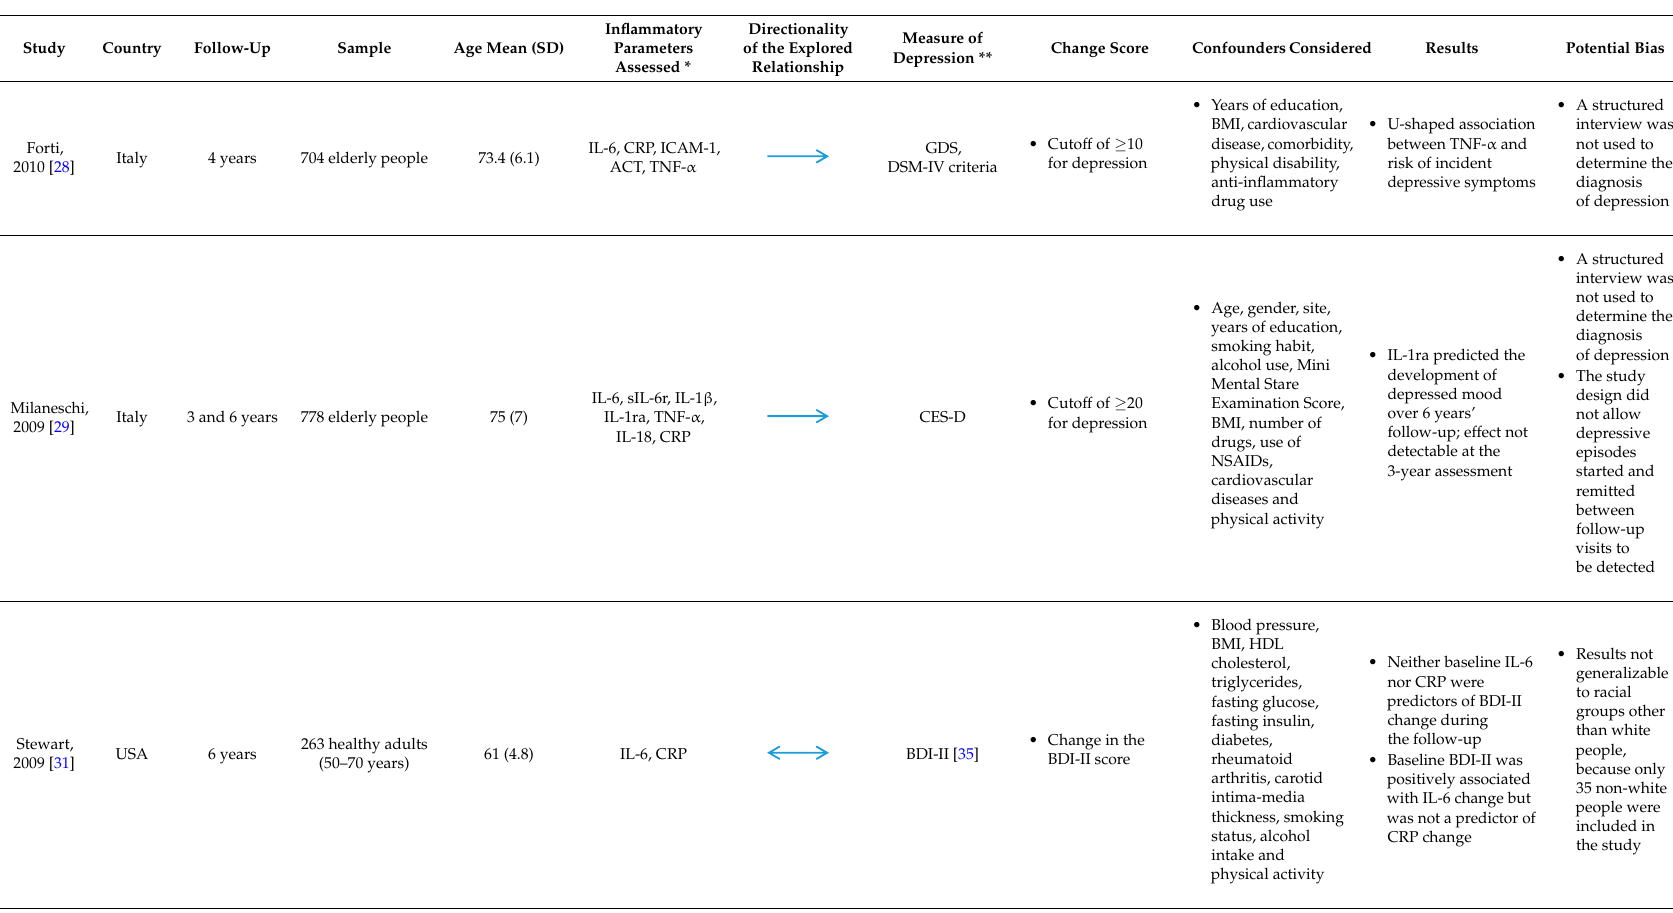
Table 1. Main characteristics of cohort studies included in the review. Table 1. Cont.